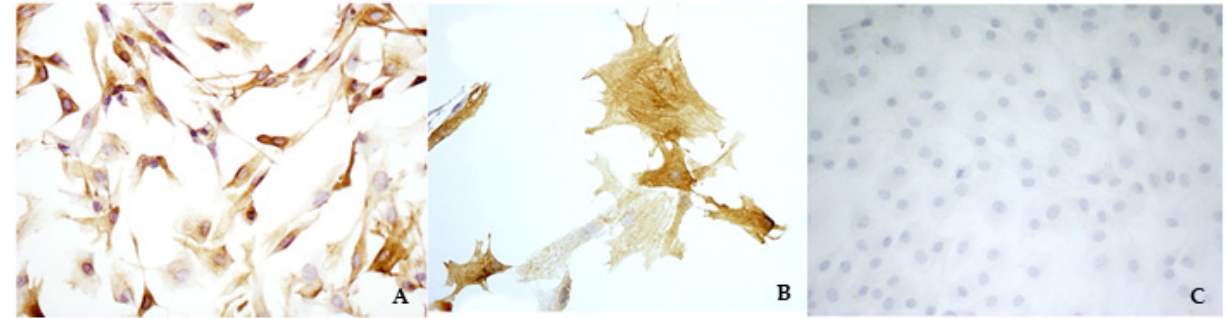
Figure 1. Immunocytochemistry analysis of bovine valvular interstitial cells (VICs) to visualize vimentin ( A ) (magnification: 10 × ), smooth muscle actin ( B ) (magnification: 40 × ), and von Willebrand factor ( C ) (magnification: 10 × ).